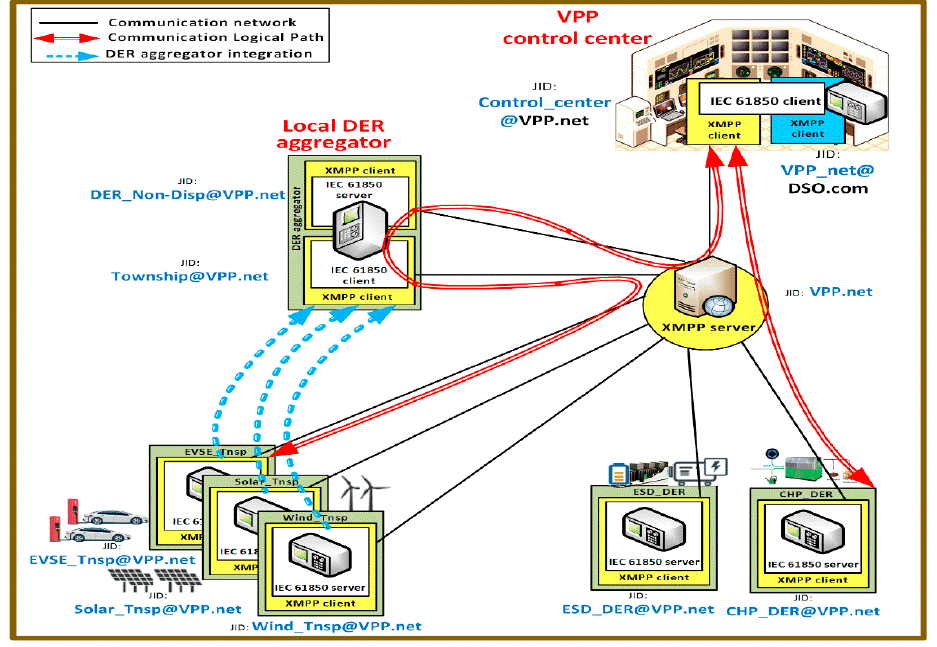
Figure 3. VPP with single domain XMPP.